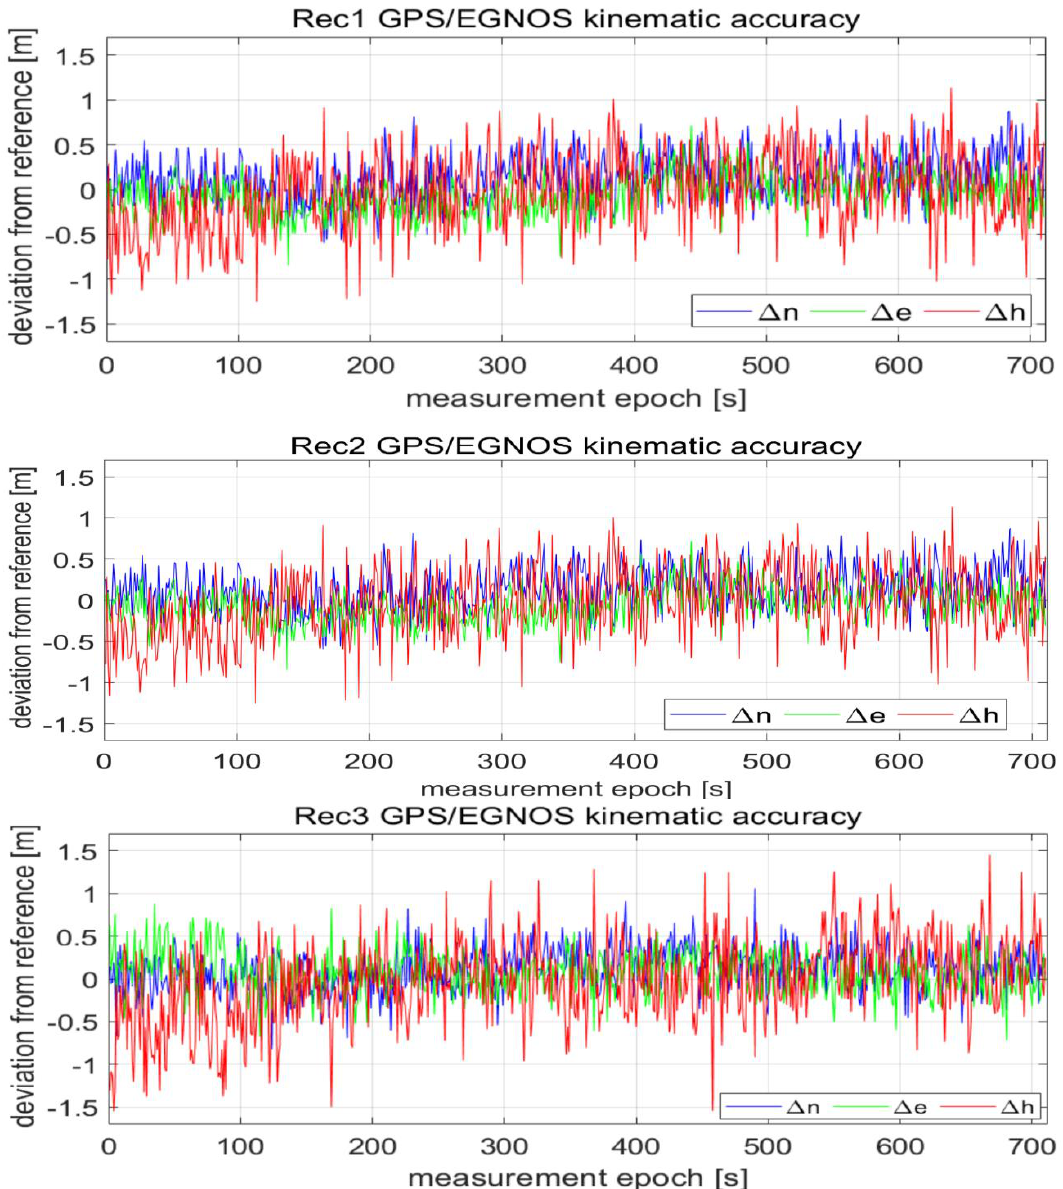
Figure 3. Accuracies in GPS kinematic positioning of individual receivers, by means of EGNOS